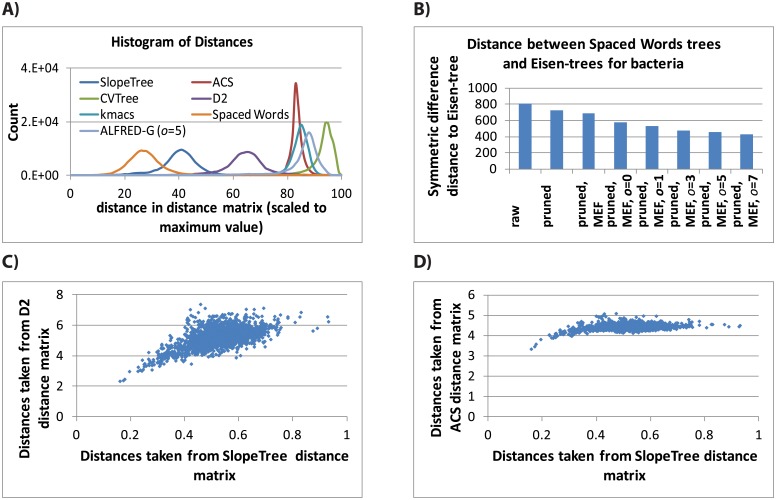
SlopeTree and other alignment-free methods.A) Histogram of scaled distances produced by each method. B) Decrease in symmetric difference distance to the Eisen-495 tree for Spaced Words method. C) SlopeTree distances to D2 distances for a matching set of randomly selected organism pairs. D) SlopeTree distances to ACS distances for a matching set of randomly selected organism pairs.